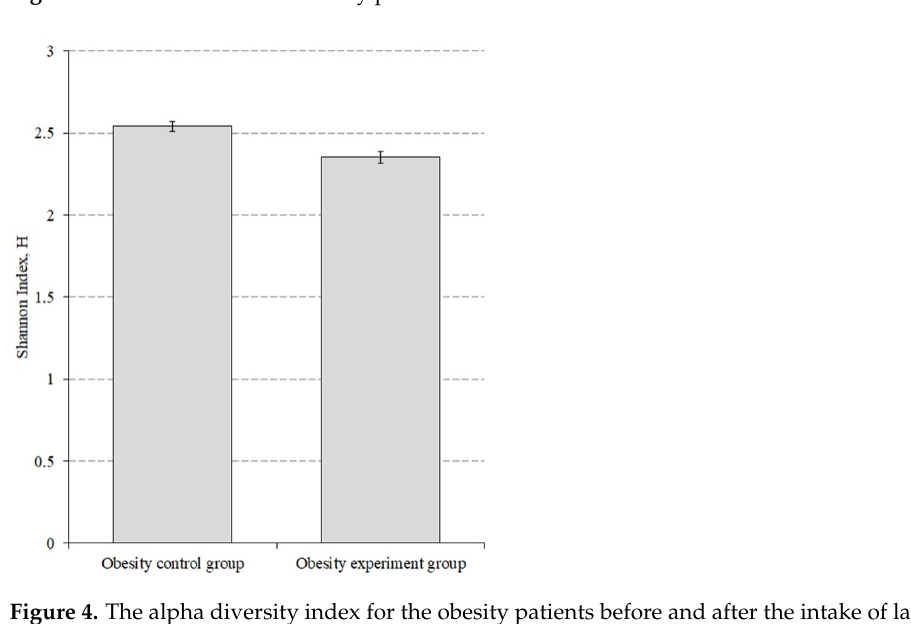
Figure 3. The microbiome of obesity patients before and after the intake of lactic acid bacteria.